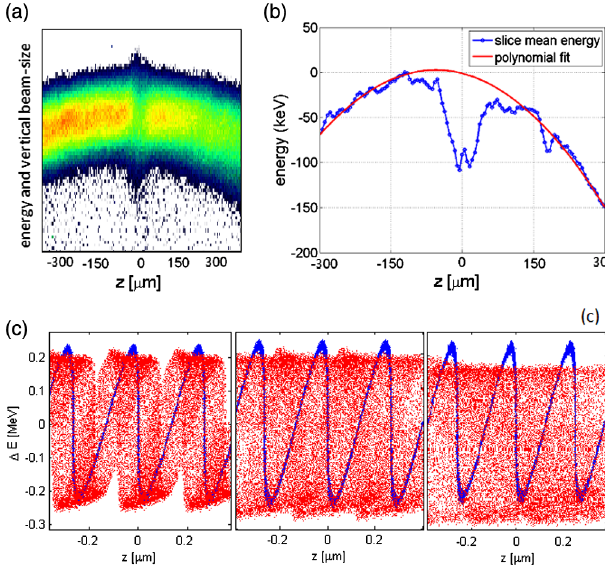
FIG. 8. Measurement of the seeded electron beam streaked out horizontally in time and vertically in energy (a) and measured average energy of longitudinal slices of the electron beam (b). In (b), the average energy of the seeded slices is lowered by 90 keV for a 56 A initial peak current and ð 700 (cid:2) 300 Þ keV of energy modulation with a 266 nm seed duration of ð 100 (cid:2) 50 Þ fs (FWHM). A CSRtrack simulation of a microbunched beam with a 7 keV slice energy spread prior to 400 keV (peak-to-peak) energy modulation is shown in (c) as it travels through the first 3 cm of the spectrometer. Prior to bunching, the peak current is 56 A and afterwards, it is 300 A. The blue, sinusoidal pattern is the particle distribution at the entrance to the bend. The red pattern shows that after 10 mm, the mean energy of the seeded portion has dropped by 15 keV, after 20 mm it has dropped by 25 keV, and above 30 mm, it has dropped by 50 keV.